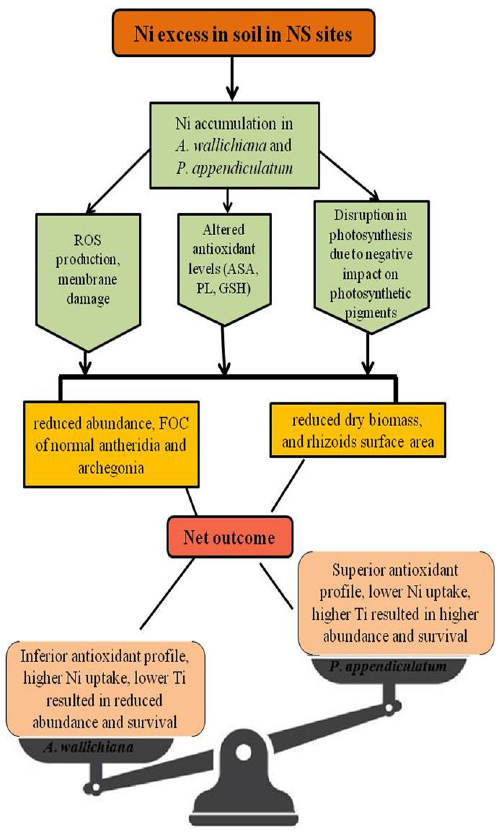
Figure 6. Proposed model representing effects of nickel (Ni) excess in natural habitats on the life cycle events of Asterella wallichiana and Plagiochasma appendiculatum . Presence of Ni excess in field (NS) conditions resulted in the reduction of overall growth and reproductive performance of both the liverworts. Ni accumulation in thalli of A . wallichiana and P . appendiculatum resulted in membrane damage due to excessive production of reactive oxygen species (ROS). Ni excess elevated antioxidant profiles in both the liverworts, especially in P . appendiculatum . Subsequent effects of Ni accumulation also caused disturbance in nitrogen metabolism (urease enzyme activity), while reduction in photosynthetic pigments in both the liverworts, with higher effects on A . wallichiana may be linked to reduced photosynthesis. Ni-induced physiological changes led to reduction in dry biomass, rhizoid surface area, abundance, frequency of occurrence of mature gametophytes (male and female) and frequency distribution and number of reproductively active archegonia and antheridia in both two liverworts, with higher effects on A . wallichiana . Results obtained from comprehensive and comparative field investigations of A . wallichiana and P . appendiculatum on NS compared with CS demonstrated that P . appendiculatum is more capable in terms of Ni excess tolerance compared to A . wallichiana . Abbreviations : reactive oxygen species (ROS), ascorbic acid (ASA), proline (PL), glutathione (GSH), frequency of occurrence (FOC), tolerance index